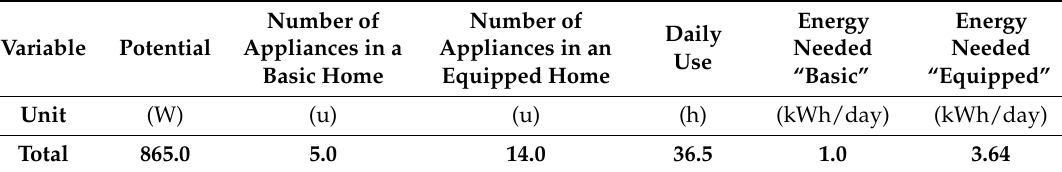
Table 2. Electricity consumption for homes isolated from the grid of the types “basic” and “equipped” updated from Reference [32].